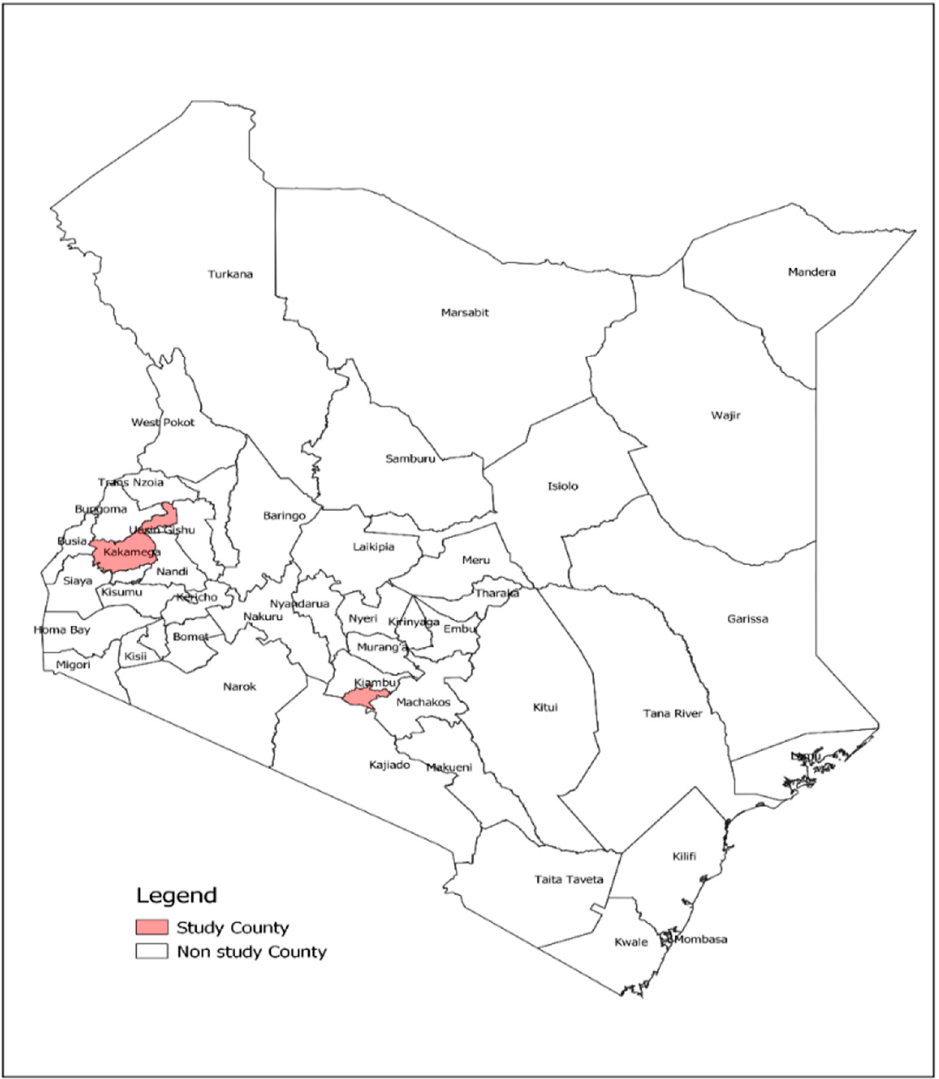
Figure 1. Map of Kenya showing the location of the two study sites: Nairobi, the capital city, and Kakamega, the rural site.